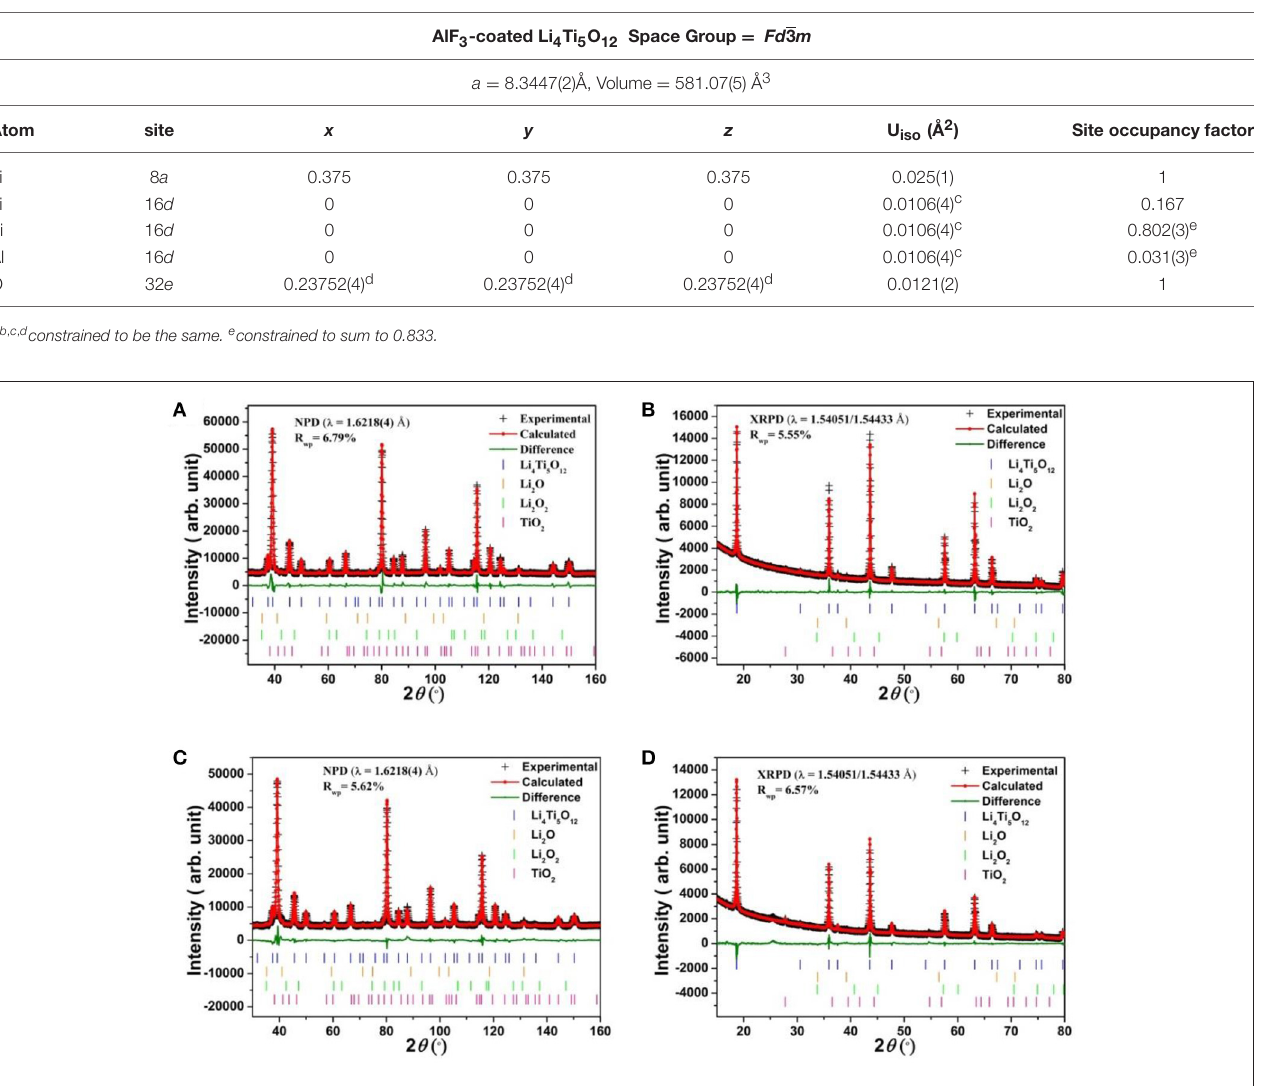
majority of the sample is composed of LNMO with Fd 3 m space group, which is considered in the following